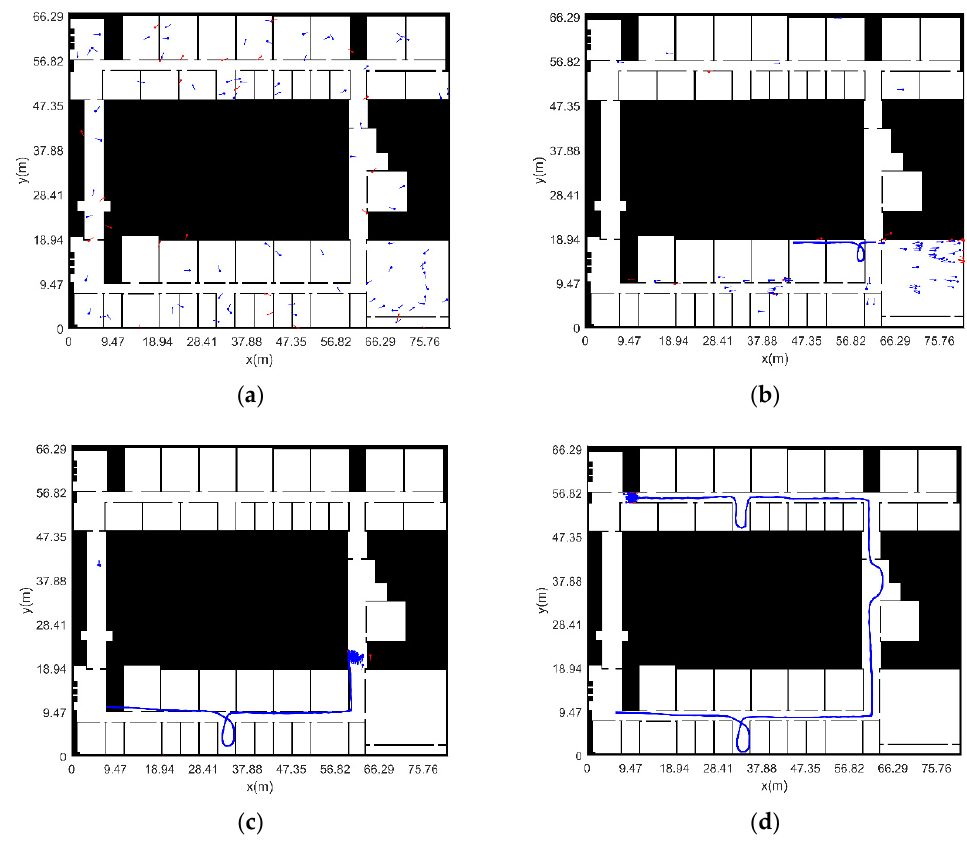
Figure 9. Sampling particle distribution and motion trace with unknown initial position and heading. ( a ) Particle distribution at initial moment; ( b ) particle distribution and motion trace of the 44th step in the motion process; ( c ) particle distribution and motion trace of the 74th step in the motion process; and ( d ) particle distribution and motion trace of the 162th step in the motion